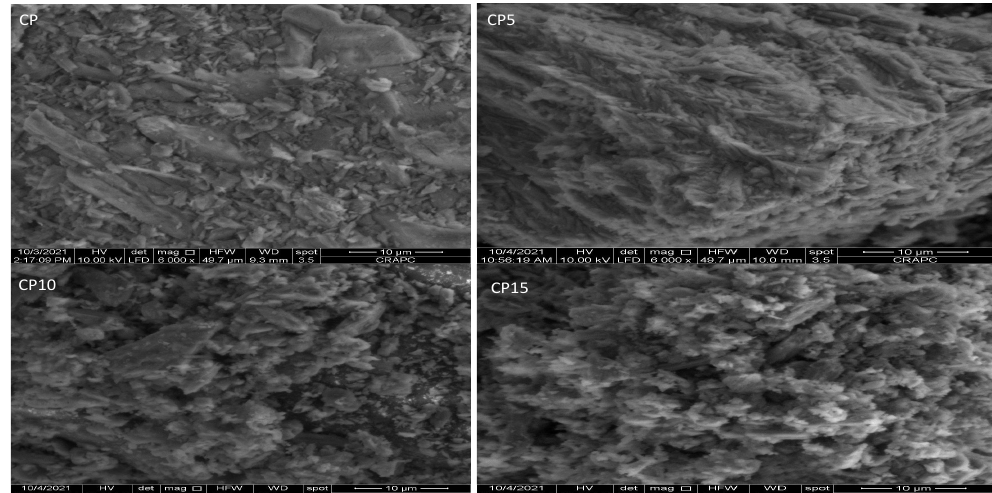
Figure 10. Scanning electron microscope images of the binder